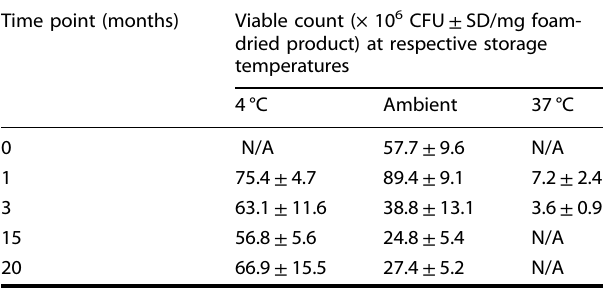
Table 2. Stability characteristics of foam-dried Ty21a-PA-01 Time point (months)